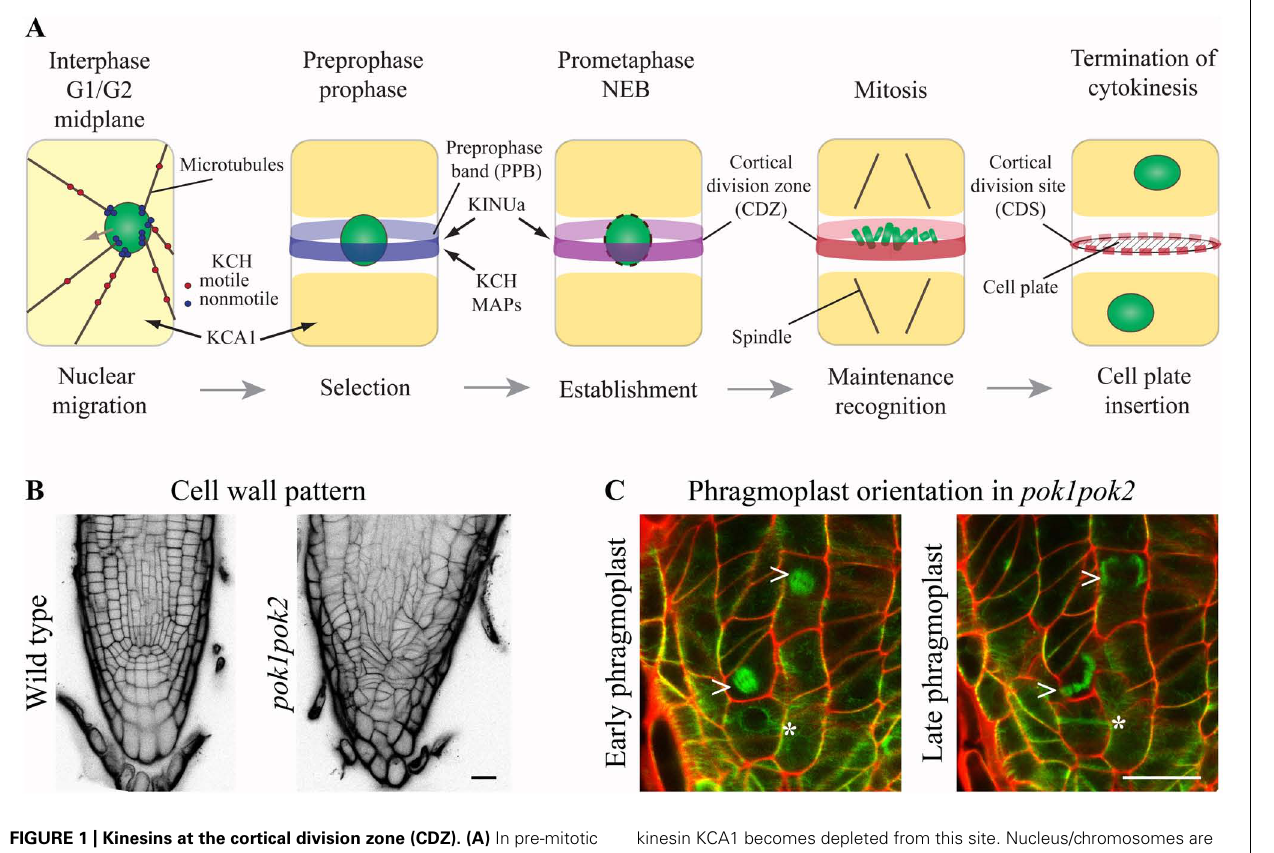
FIGURE 1 | Kinesins at the cortical division zone (CDZ). (A) In pre-mitotic cells, nuclear migration to the cell center is accomplished by microtubule (MT) force-dependent sensing of cell geometry potentially mediated by KCH kinesins.The preprophase band (PPB) circumscribes the future division plane at the cell cortex. Several MT-associated proteins (MAPs) and kinesin AtKINUa and the Arabidopsis KCH (AtKinG) are recruited to the PPB/CDZ, while the plasma membrane resident